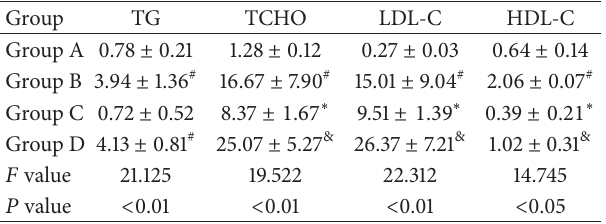
Table 3: Expressions of blood lipid indices ( 𝑥 ± 𝑠 ,